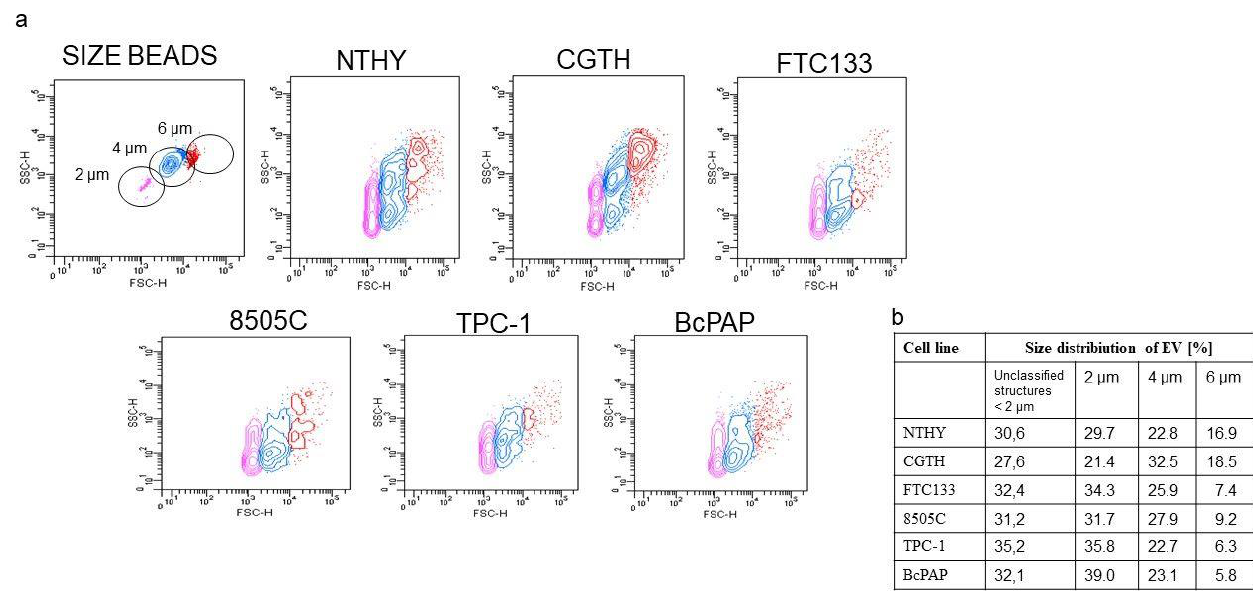
Figure 2. Analyzing the sizes of extracellular vesicles (EVs) released by thyroid cancer cell lines. ( a ). Gating strategy for analyzing EV sizes. Visualization of size beads (with diameters of 2, 4, and 6 μm) shown in a forward scatter (FSC) and side scatter (SSC); ( b ). Size distribution of EVs released by the different thyroid cell lines. NTHY: cell line derived from normal human thyroid follicular cells; CGTG: Thyroid gland squamous cell carcinoma; FTC-133: follicular thyroid carcinoma; 8505c: ana- plastic thyroid carcinoma; TPC-1: thyroid gland papillary carcinoma; BcPAP: thyroid gland papil- lary carcinoma. Full characteristics of the used cell lines are provided in Supplementary Table S1.